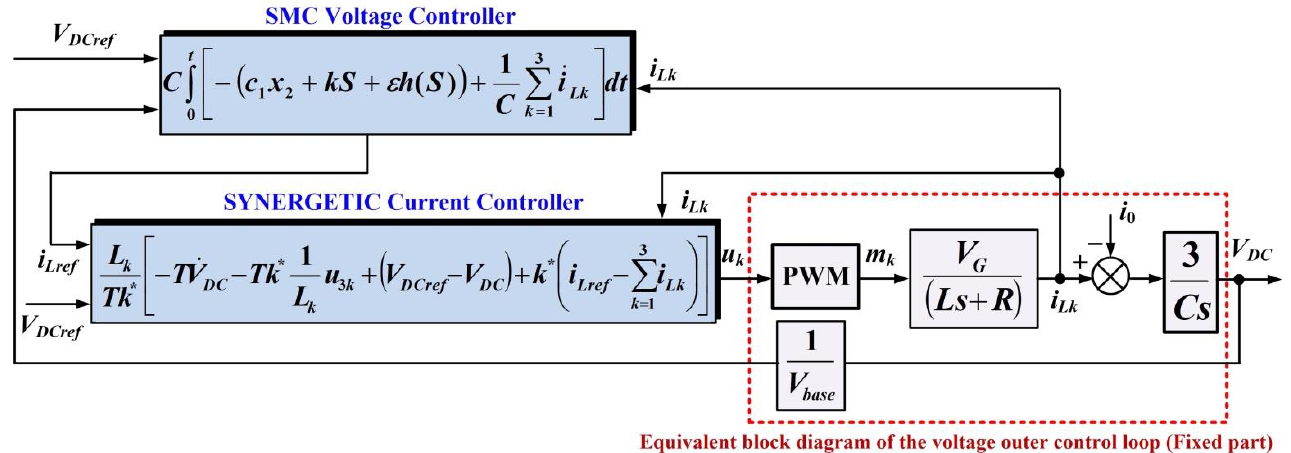
Figure 10. Block diagram modeled using the transfer function for the control system of the power electronic converter using an SMC controller for the voltage outer control loop and a synergetic controller for the current inner control loop.